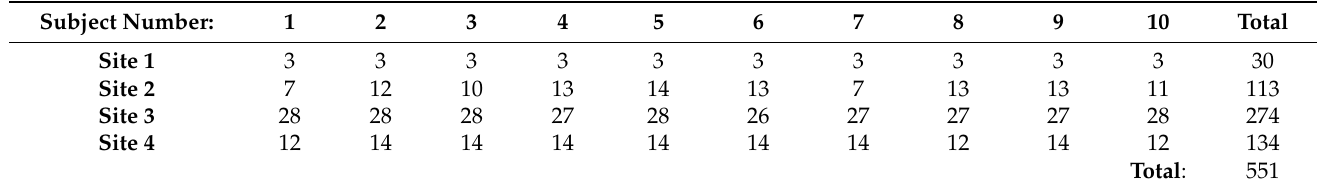
Table 1. Distribution of MRI slices, used for training, by different subjects and sites.